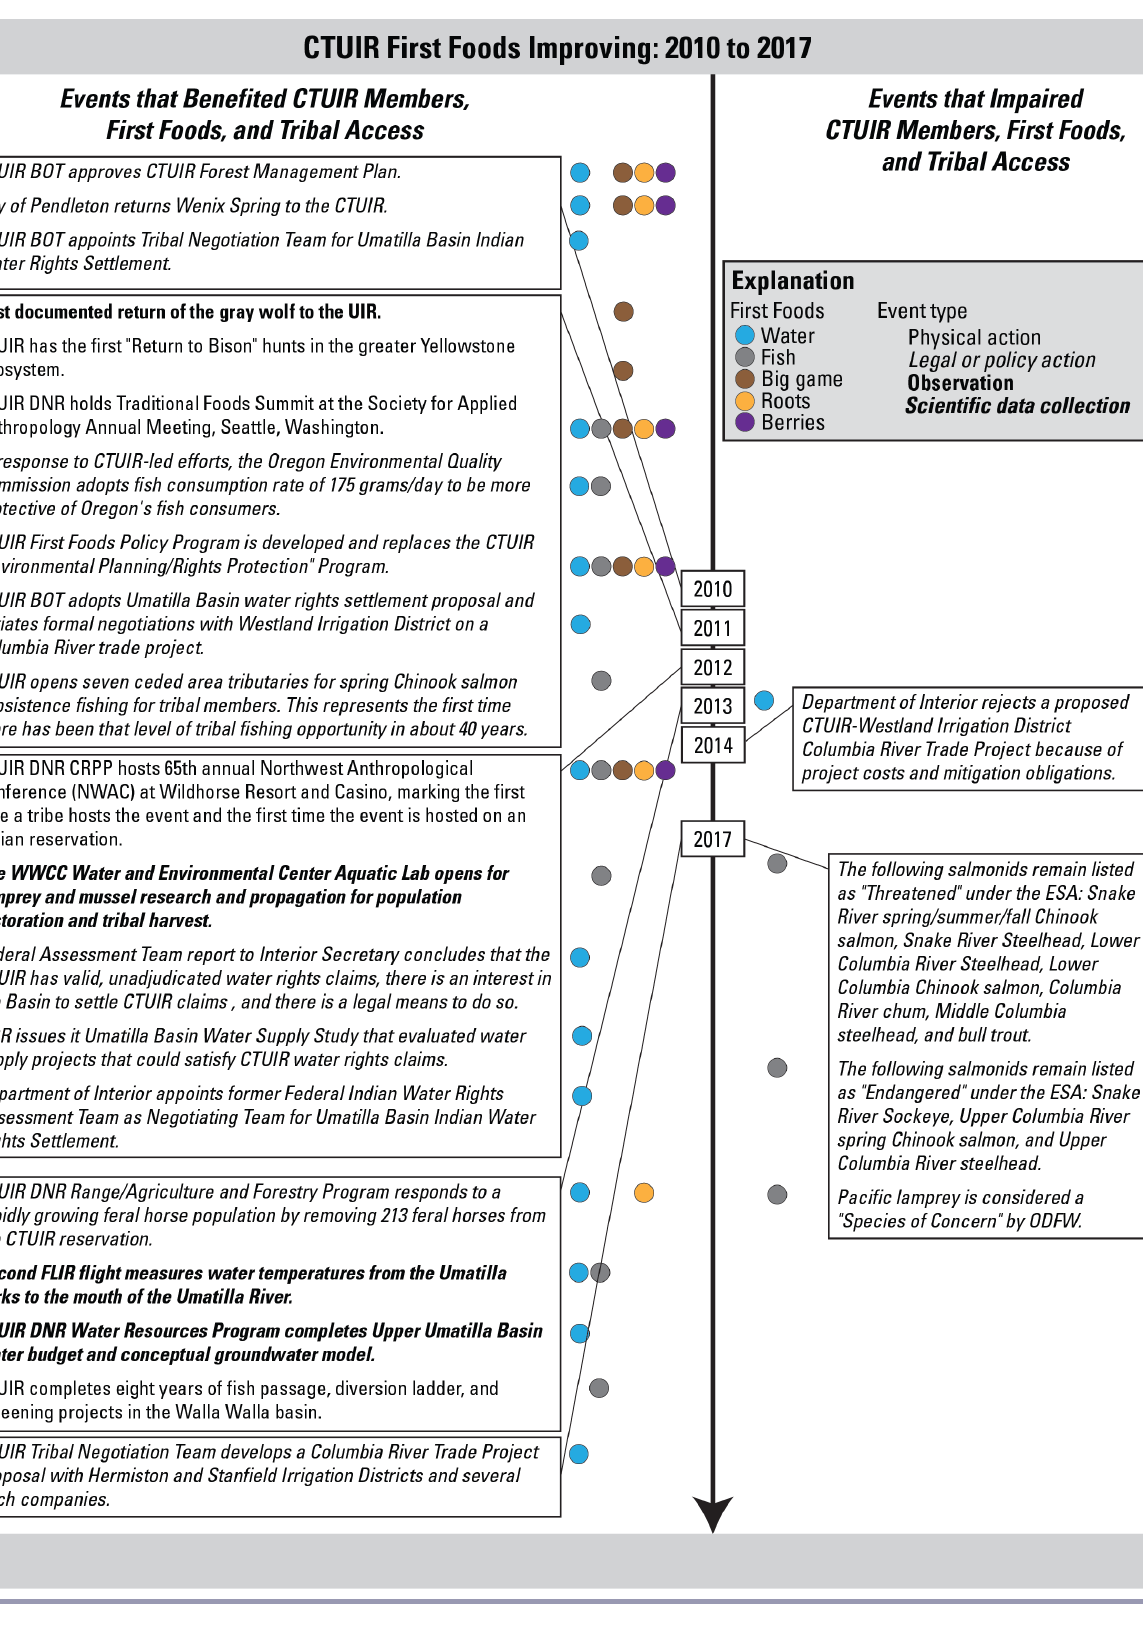
Fig. 9 . Timeline of representative events benefiting or diminishing First Foods and tribal access to them, 2010 to